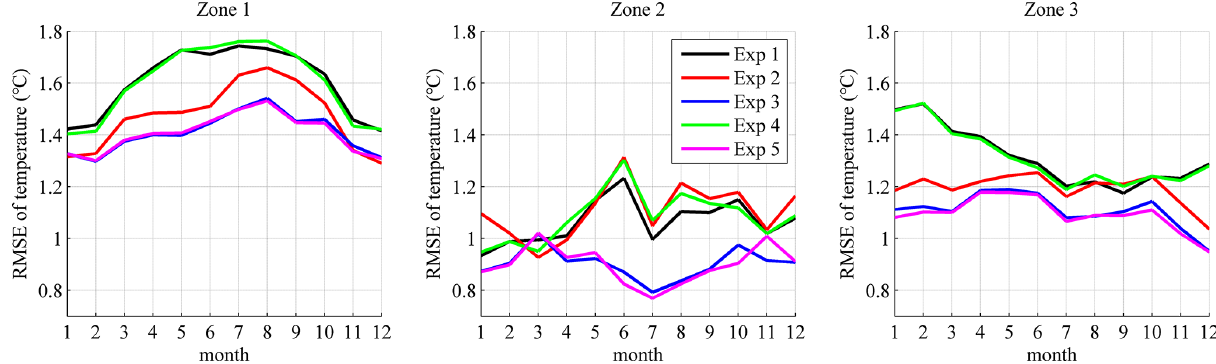
Figure 8. Variation of the RMSE of temperature between the simulated monthly mean results in the five experiments and the monthly WOA13 data in Zones 1–3 (shown in Fig.